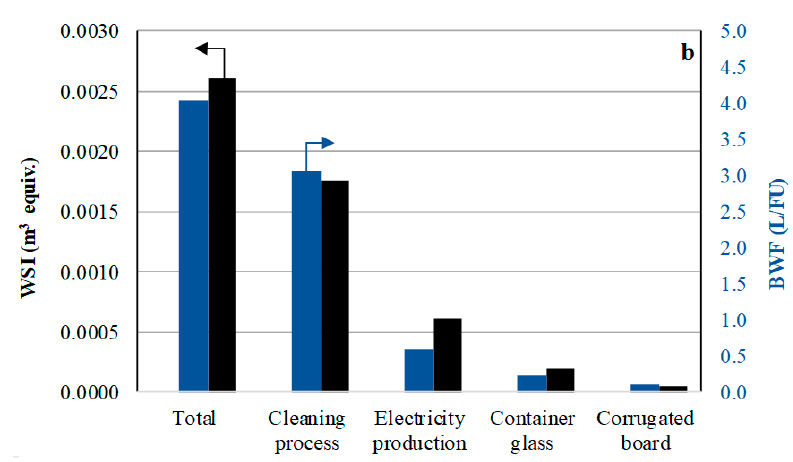
Figure 13. Total blue water footprint (BWF) (  ), water scarcity index (WSI) (  ) and contribution of the different processes linked to the winery stage for ( a ) case study I and ( b ) case study II.